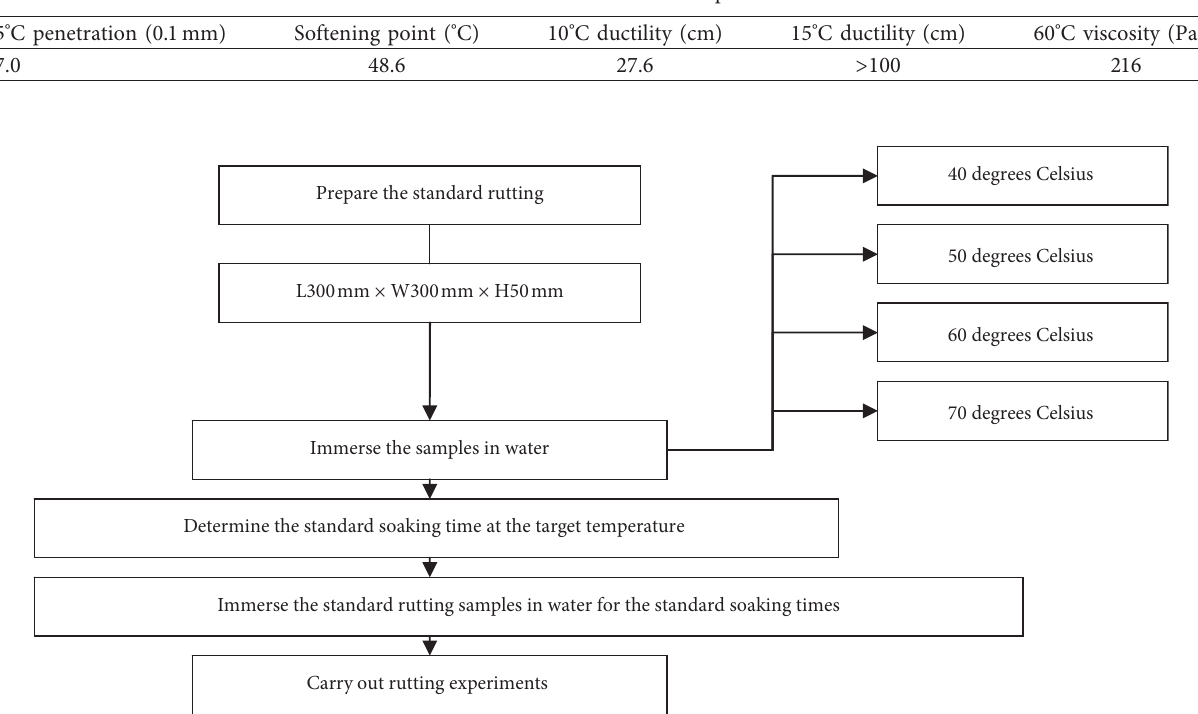
Figure 1: Flowchart of asphalt concrete immersion test under high